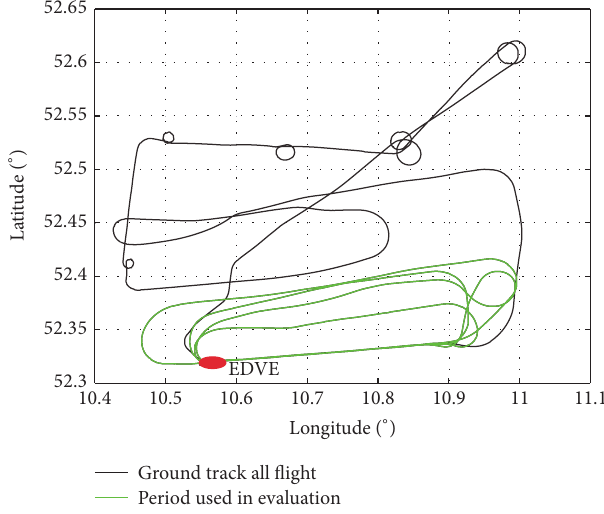
Figure 5: Ground track of the test flight around Braunschweig (ICAO identifier EDVE). The part used for the evaluation is shown in green.